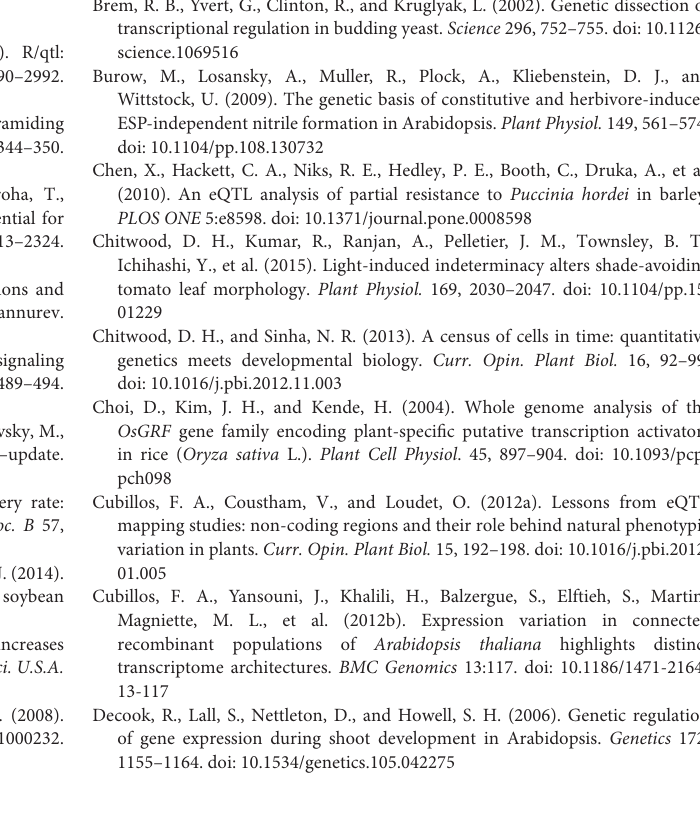
FIGURE S2 | Linkage map of T65/Bhadua RILs. FIGURE S3 | Overview of genome-wide transcriptome data. (A) Results of normalization of the microarray data for the RILs and their parents. (B) Dendrogram of the RILs and their parents based on microarray data. Euclidean distances and the complete linkage method were used for hierarchical clustering. FIGURE S4 | Statistical distribution of TIL, PH, and NEI among the RILs and their parents. (A) TIL, (B) PH, and (C) NEI are shown. White and black arrowheads represent the phenotypic values for T65 and Bhadua rice, respectively. Abbreviations: TIL, total internode length; PH, plant height; NEI, number of elongated internodes. FIGURE S5 | Overview of phQTL data of the RILs. LOD statistics of phQTLs for TIL (A) , PH (B) , and NEI (C) . Arrows point to the pseudo-marker or marker positions. The candidate regions of qRIE1 and qRIE12 (Kawano et al., 2008) are shown with blue lines. Abbreviations: TIL, total internode length; PH, plant height; NEI, number of elongated internodes; and RIE, rate of internode elongation. The red horizontal line indicates LOD = 3. FIGURE S6 | Overview of eQTL hotspot size significance profile. The eQTL hotspots in the 12 rice chromosomes were derived with a quantile-based permutation approach (Neto et al., 2012). Data are presented essentially as shown in Figure 4A